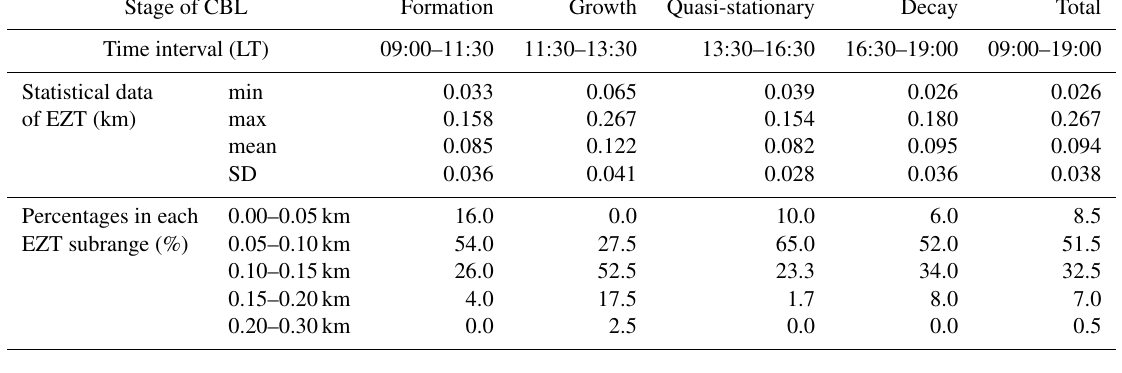
Table 1. Statistics of the EZT obtained on 31 January 2020. Stage of CBL Formation Growth